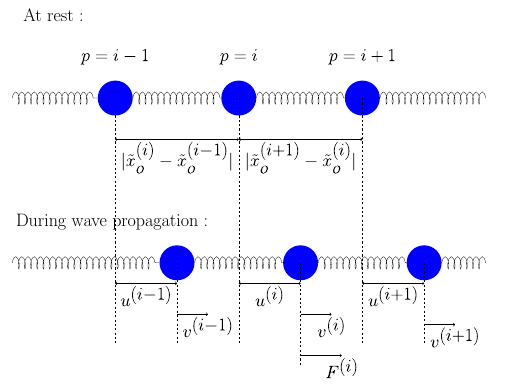
Figure 2. Prestressed chain of granular elements during dynamic wave